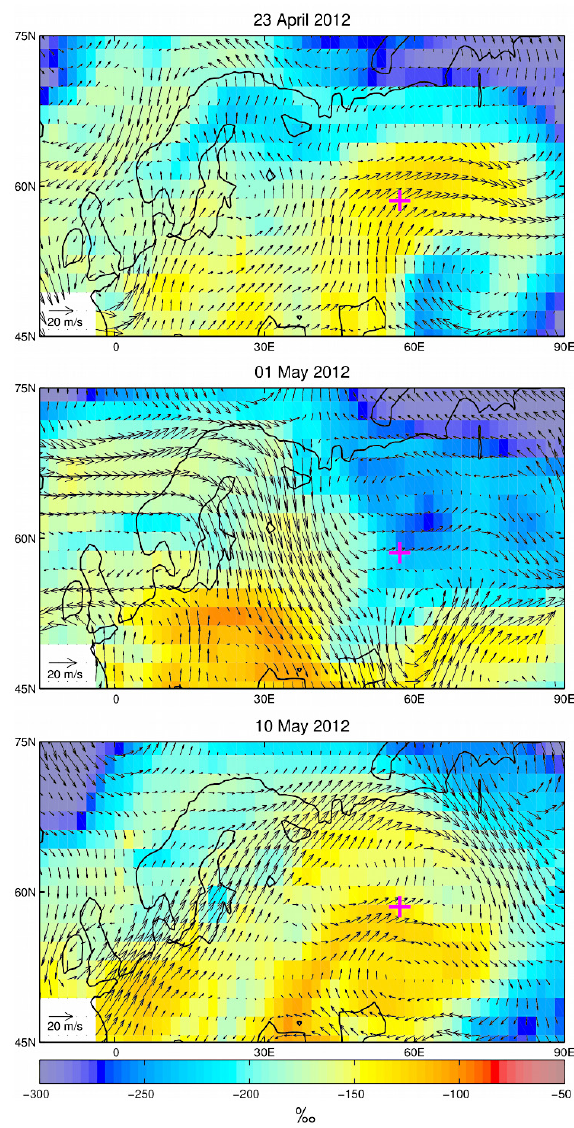
Figure 8. Horizontal wind flow at 850hPa (vectors) and δ D compo- sition of the total water column (coloured pattern) for (a) 23 April, (b) 1 May, (c) 10 May for the region 45–75 ◦ N, 15 ◦ W–90 ◦ E as simulated by ECHAM5-wiso. The location of Kourovka station is marked by a red